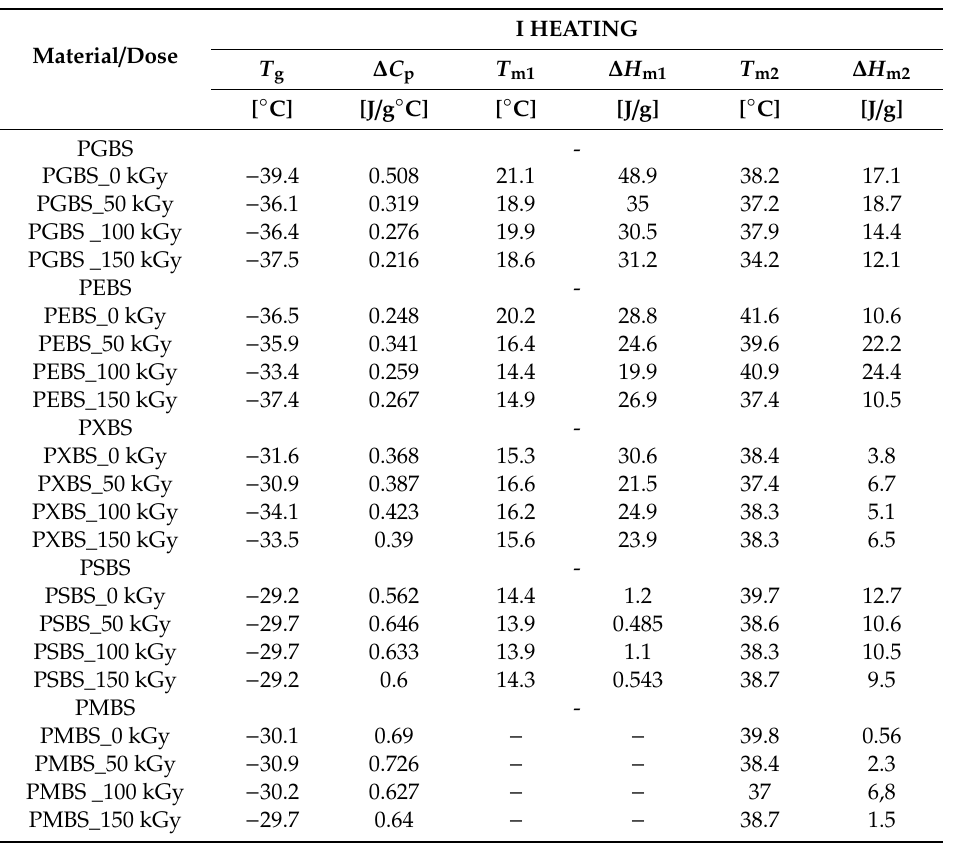
Table 3. DSC termograms of poly(glycerol sebacate-co-butylene sebacate) (PGBS), poly(erythrytol sebacate-co-butylene sebacate) (PEBS), poly(xylitol sebacate-co-butylene sebacate) PXBS, poly(sorbitol sebacate-co-butylene sebacate) (PSBS), poly(mannitol sebacate-co-butylene sebacate) (PMBS) before and after irradiation.